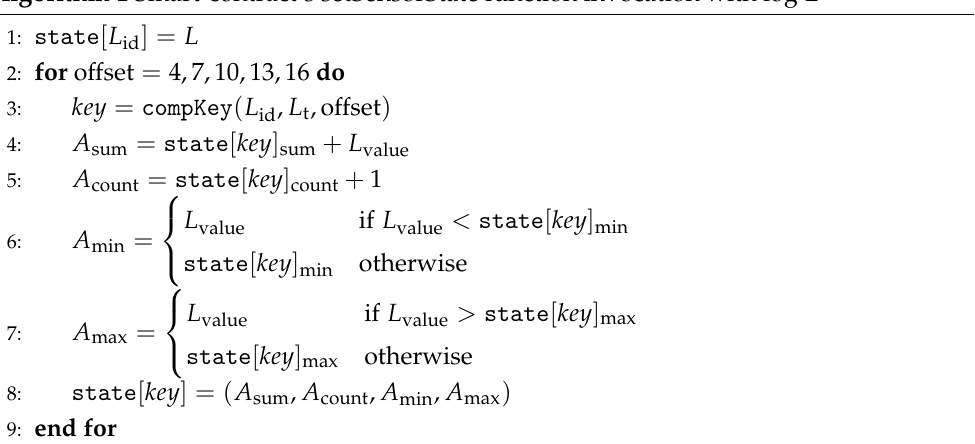
Algorithm 1 Smart-contract’s setSensorState function invocation with log